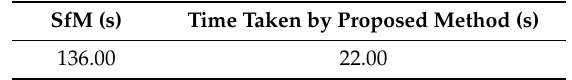
Table 4. Evaluation results in terms of time needed for reconstruction (different reconstruction algorithms). SfM